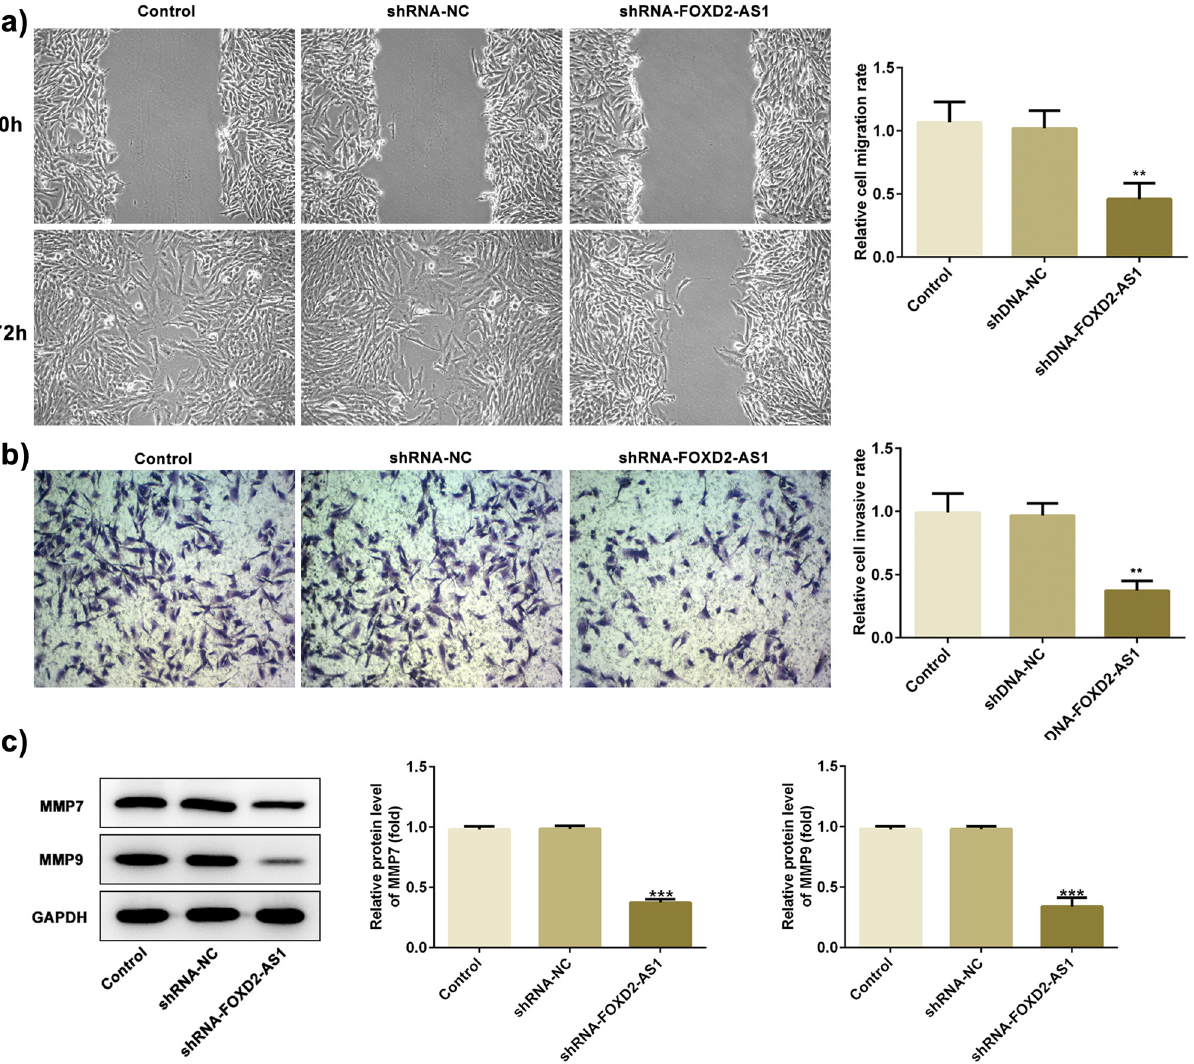
Figure 2: Knockdown of FOXD2 - AS1 suppressed cell migration and invasion of U251 cells. ( a ) Representative pictures of wound healing assay ( left ) and quantitative analysis results of relative migration rate ( right ) . Magni fi cation × 200. ( b ) Representative pictures of Transwell assay ( left ) and quantitative analysis results of relative invasive rate ( right ) . Magni fi cation × 200. ( c ) Results of western blot showed that FOXD2 - AS1 knockdown reduced the expressions of invasiveness - related proteins MMP7 and MMP9. Magni fi cation × 200. N = 5, ** P < 0.01 and *** P < 0.001 vs. shRNA - NC and